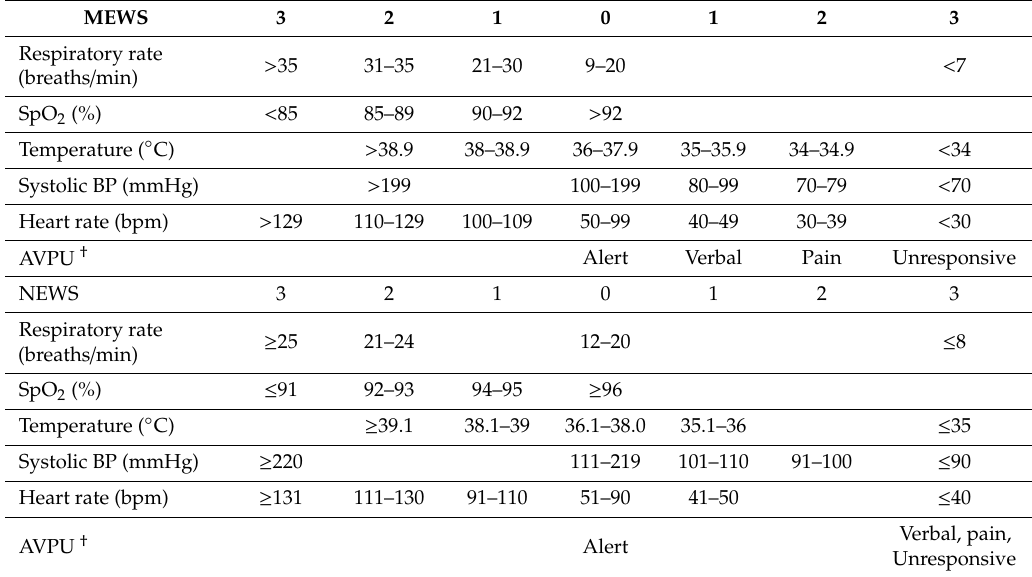
Table 2. Modified Early Warning Score (MEWS) and National Early Warning Score (NEWS) [2,21].